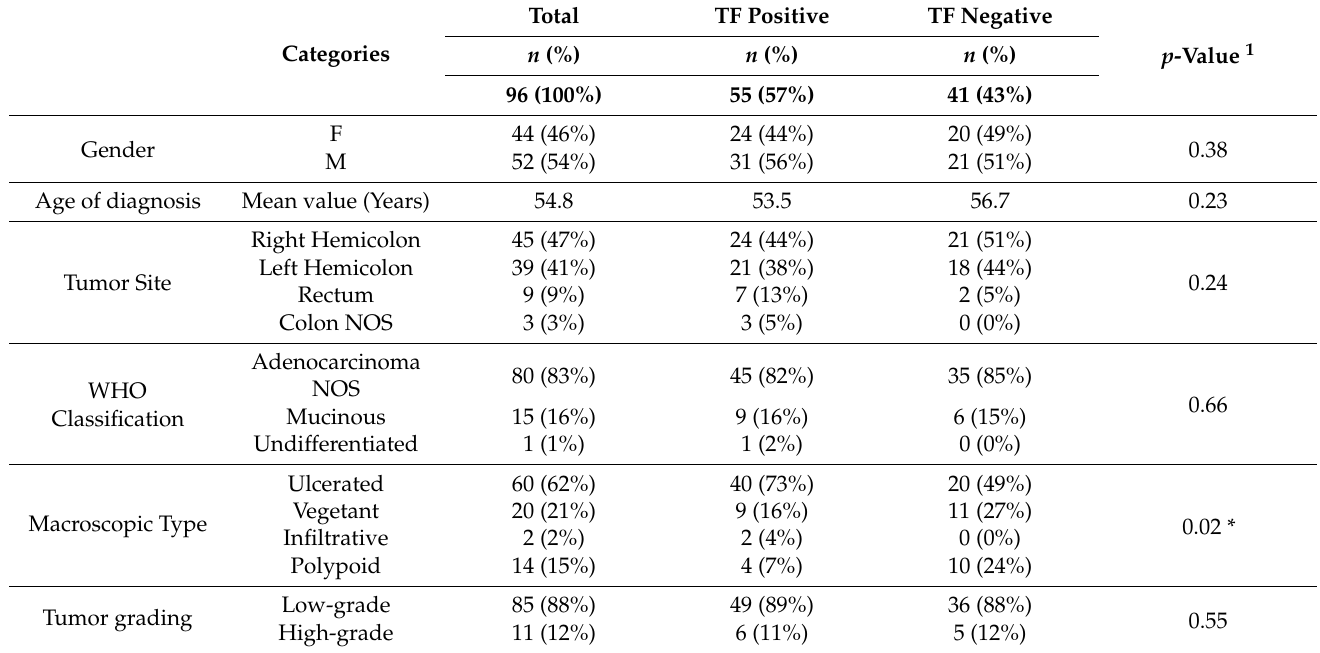
Table 1. Thomsen–Friedenreich (TF) expression and clinicopathological